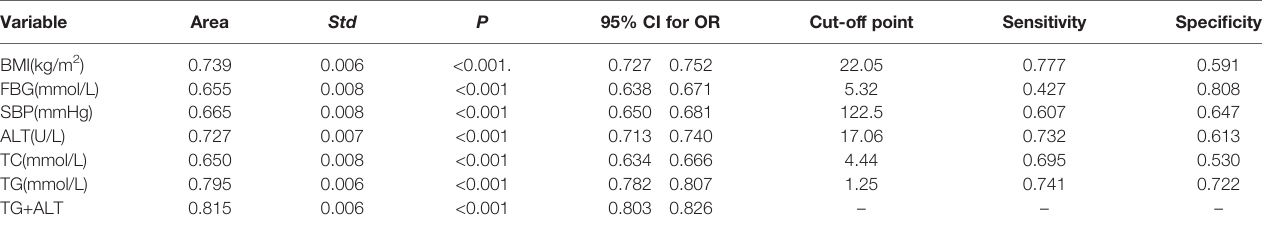
TABLE 7 | The ROC curve was used to evaluate the diagnostic ef fi cacy of index in the diagnosis of non-obese fatty liver disease. Variable